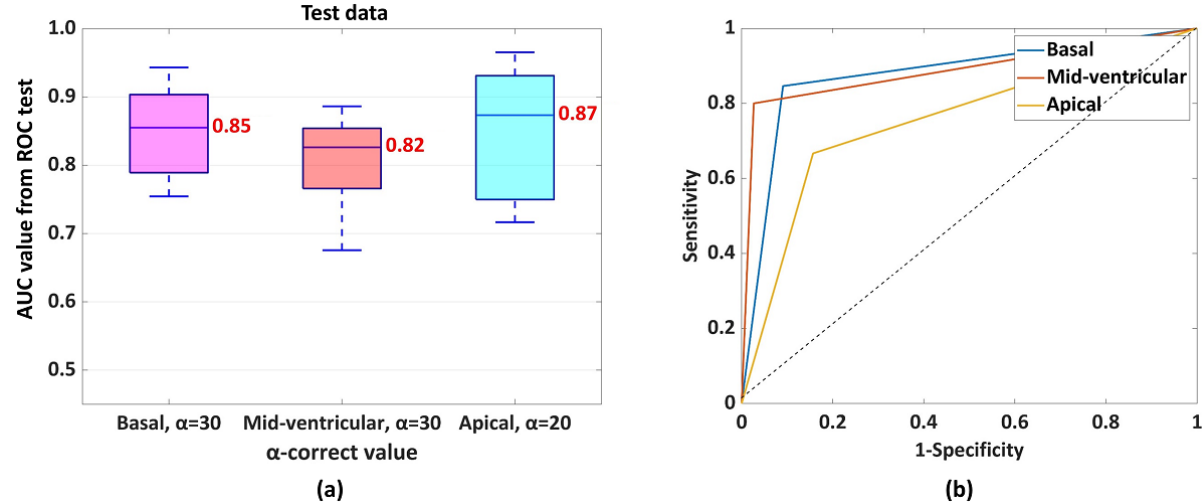
Figure 5. (a) Average of 10 k-fold cross-validation tests. Accuracy of detecting infarcted segments using the proposed method with α correct in basal, mid-ventricular, and apical slices using test data from the k-fold cross-validation tests. (b) An example of an ROC test result using the test data. AUC: area under the curve; ROC: receiver operating characteristic.